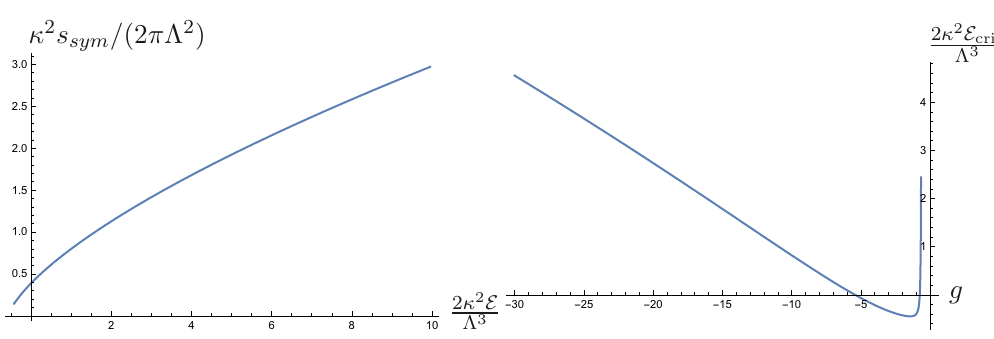
= 0, of sBBL model as hO i i Z 2 -symmetry